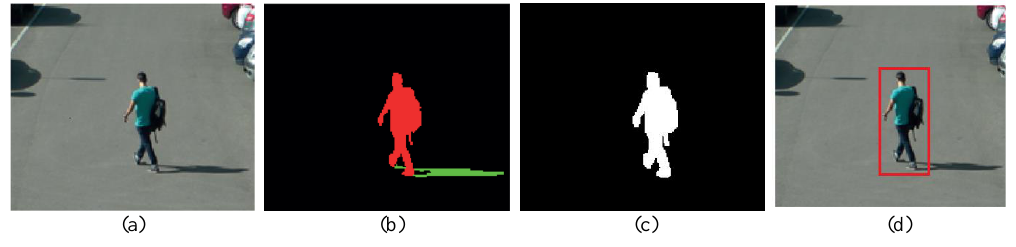
Figure 2. An example of shadow and motion detection in a real outdoor video: ( a ) an input frame; ( b ) subtracted background and detected shadow, where foreground pixels are marked in red color, whereas shadow pixels are marked in green color; ( c ) silhouette after removing shadow; and ( d ) moving object